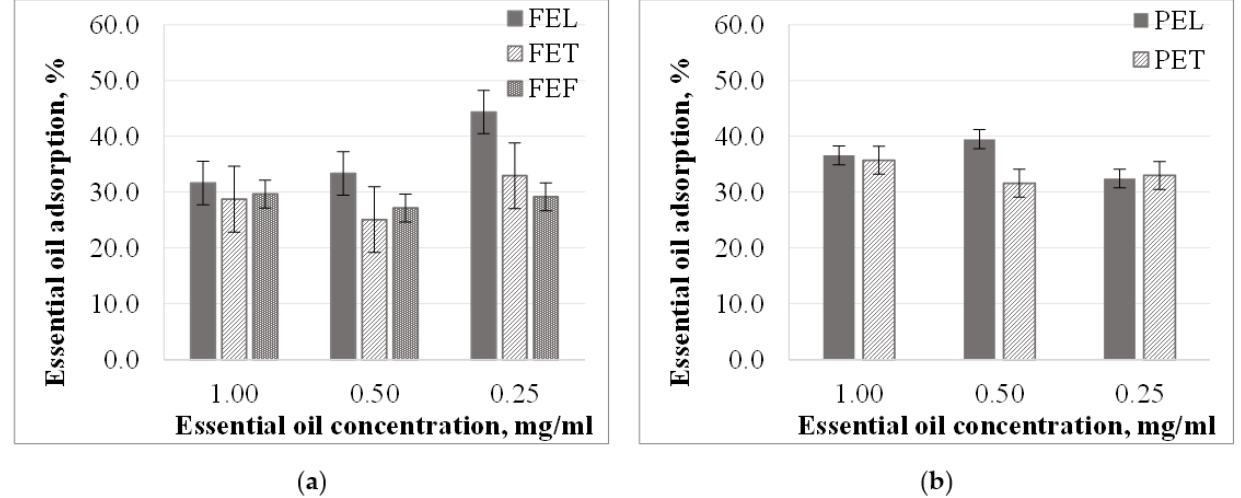
Figure 3. Essential oil adsorption (%) in ethanol solutions in the case of ( a ) particles from F granules; ( b ) particles from P granules.